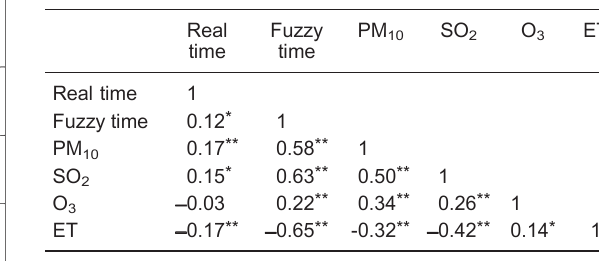
Table 2. Pearson’s correlation coefficient values for the atmo- spheric variables, average length of hospitalization (real time) and time provided by the model (fuzzy time), Sa˜ o Jose´ dos Campos, SP, Brazil, 2009.